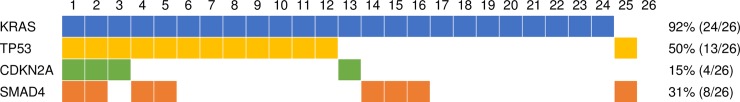
The detection rates of mutations of KRAS, TP53, CDKN2A, and SMAD4.